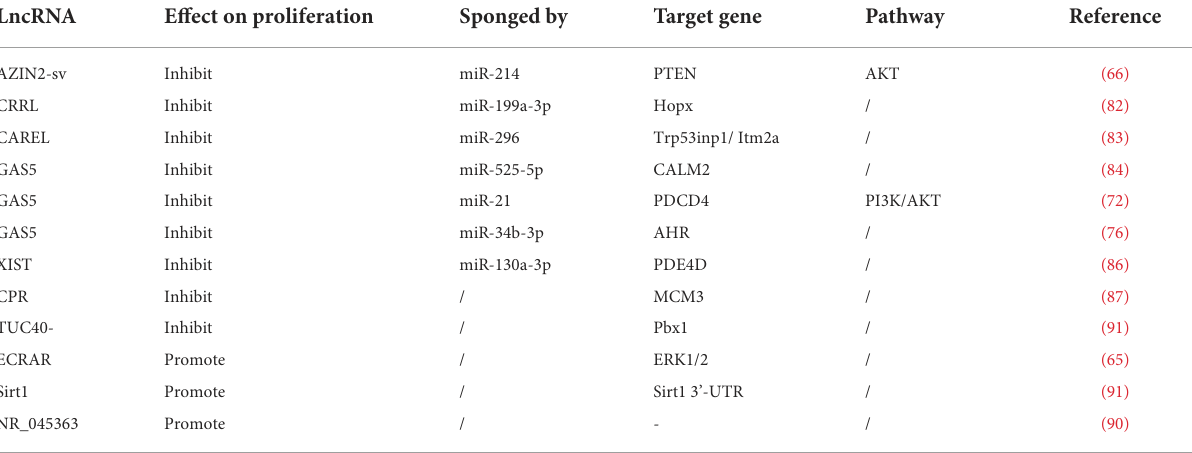
TABLE 3 A summary of the lncRNAs on cardiomyocyte proliferation and the potential mechanism. LncRNA Effect on proliferation Sponged by Target gene